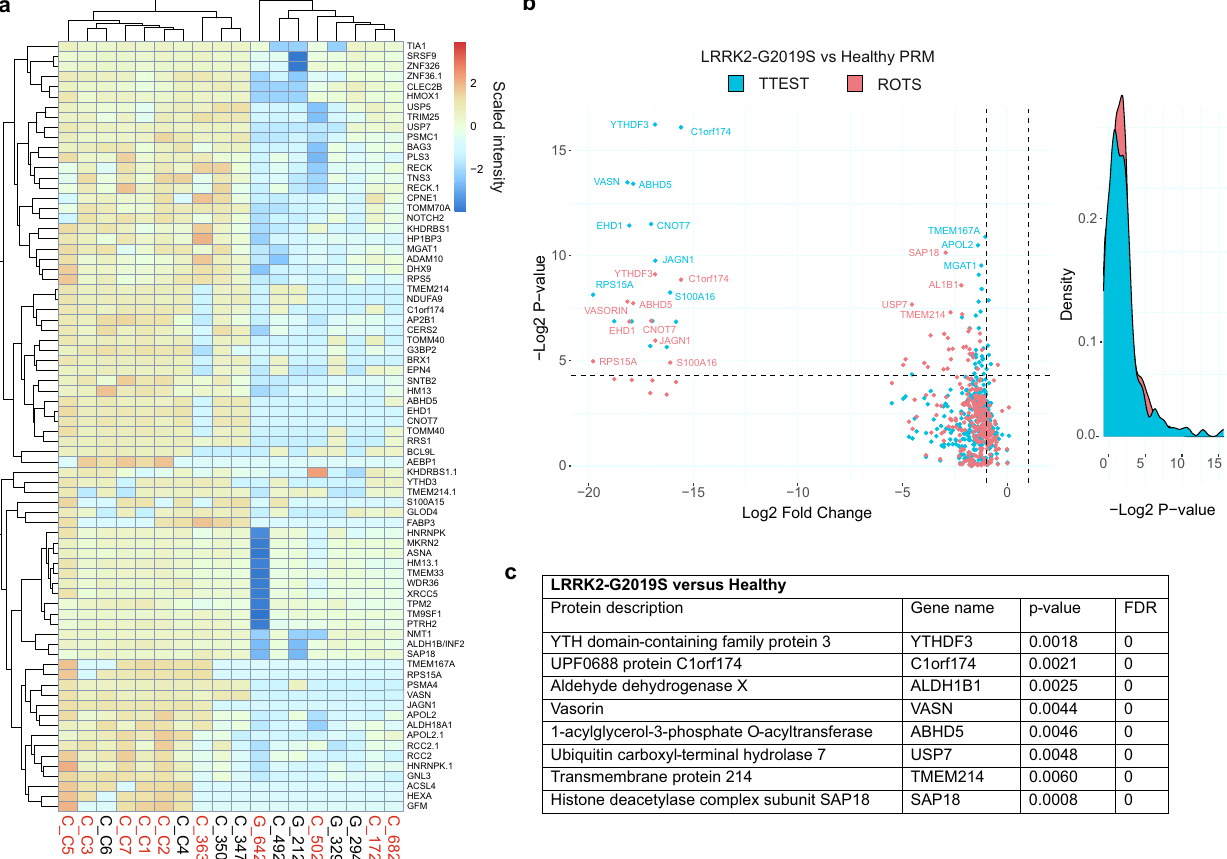
Fig. 3 PRM validation of protein homeostasis changes in LRRK2-G2019S patient cells. Targeted proteomics (PRM quanti fi cation of peptides from Fig. 2b) was carried out to validate protein intensity differences observed from AHA-labeled, de novo synthesized proteins from total lysates of patient cells. a Hierarchical clustering of PRM results shows overall protein intensities in fi broblasts from LRRK2-G2019S and healthy controls. Proteins with p -value < 0.05 from either ROTS and/or t-test are shown. b Volcano plot of PRM results from LRRK2-G2019S vs healthy. P -values from ROTS and t -test statistical tests are shown. Red sample label indicates female gender. c The top changing proteins with FDR = 0 from ROTS test are